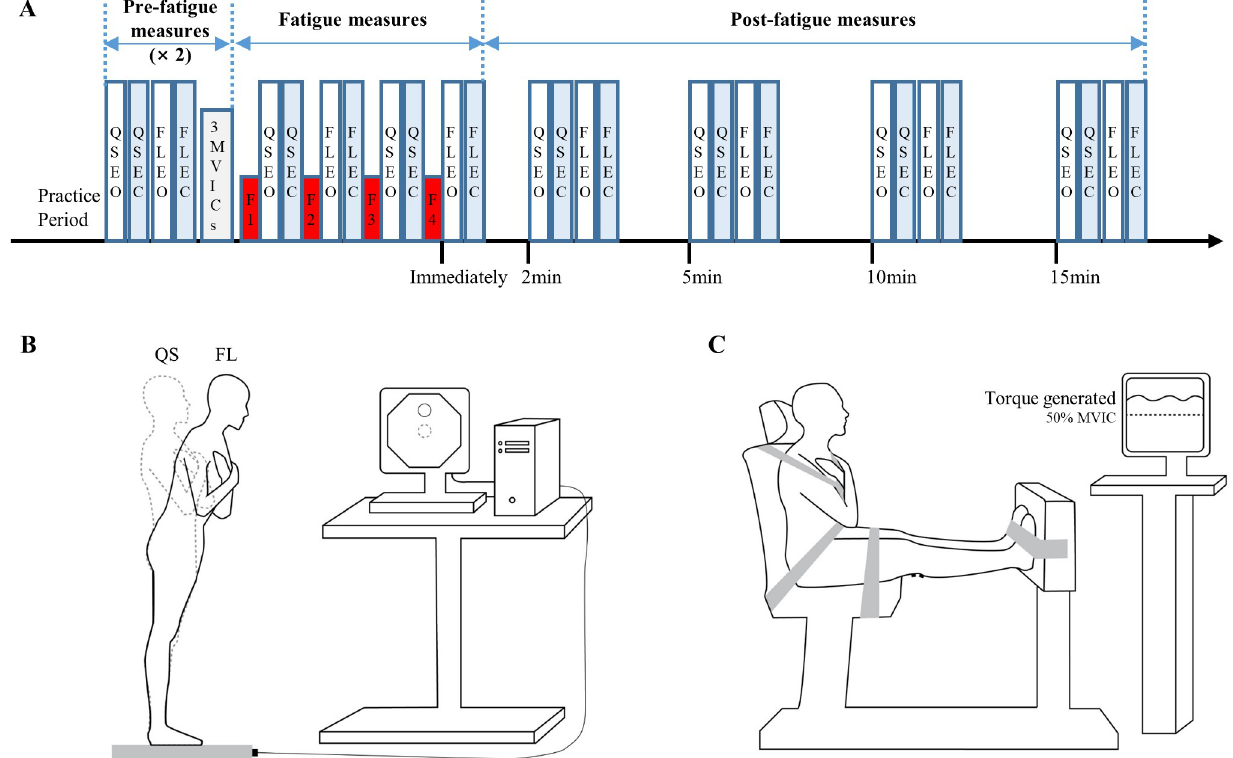
Fig 1. Schematics of the experimental protocol. The schematics include experimental procedures (A), and experimental setup for the postural tasks (QS vs. FL) performed on a force platform with the representation of the COP on a computer screen (B) and sustained isometric exercise of ankle plantar flexors on a dynamometer (C). QS: quiet standing; FL: standing forward lean task; EO: eyes open; EC: eyes closed; F1-F4: four submaximal fatiguing isometric contractions of ankle plantar flexors; MVIC: maximal voluntary isometric contraction; circle: 70% anterior limit of stability (LOS) target for the FL task; dotted circle: 0% LOS target for the QS